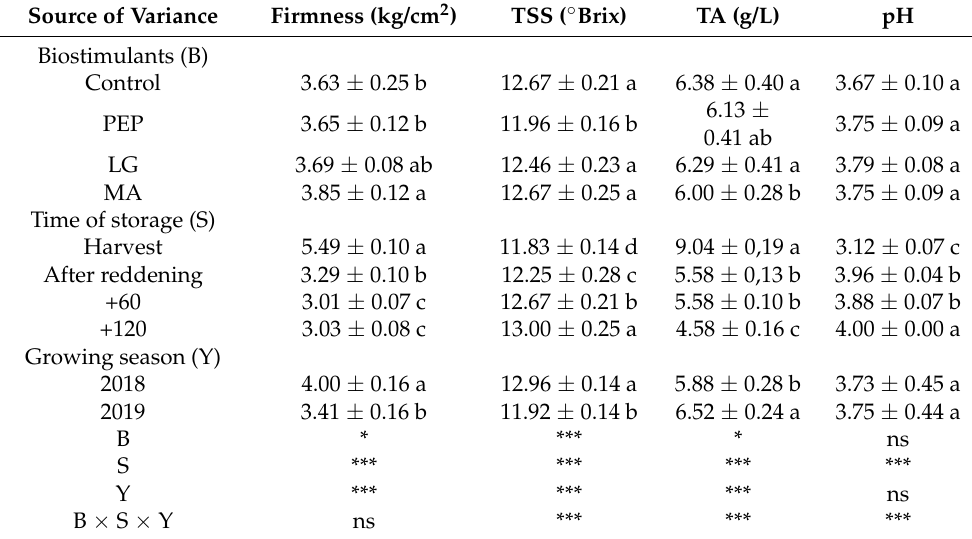
Table 3. Effects of biostimulants LG (seaweed mix + zinc + potassium), PEP (protein hydrolysates), and MA (microalgae) on flesh firmness, total soluble solids (TSS), titratable acidity (TA), and pH of the Annurca fruits at harvest, after reddening, and during the cold storage (+60 and +120 days). Source of